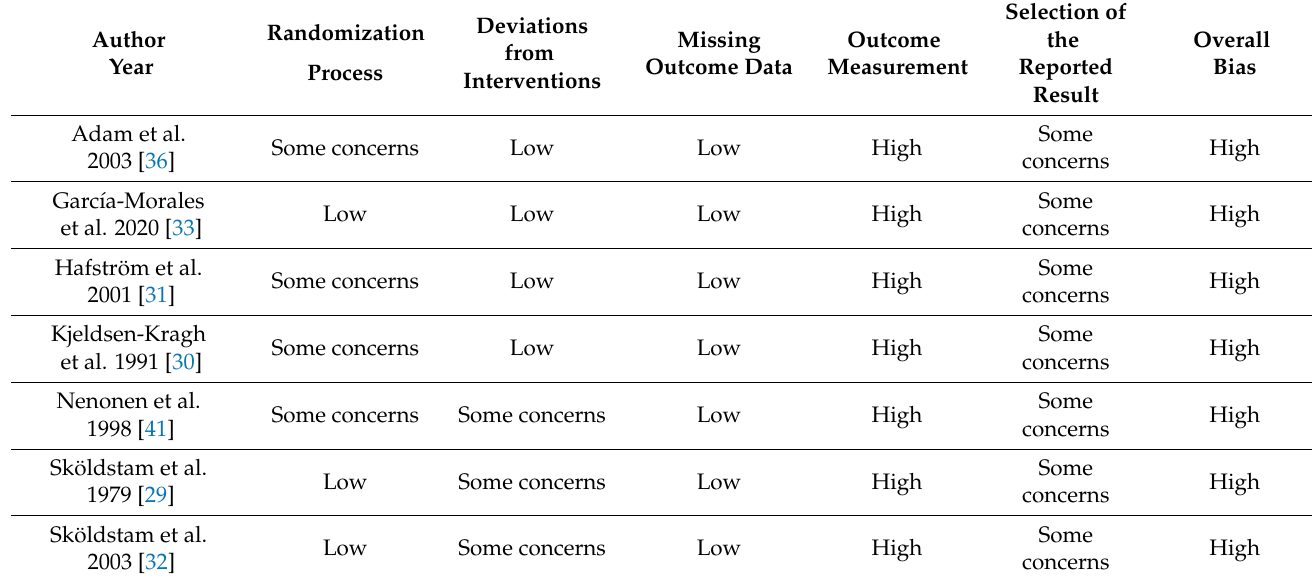
Table 2. Risk of bias assessment of randomized controlled trials for the primary outcome pain.